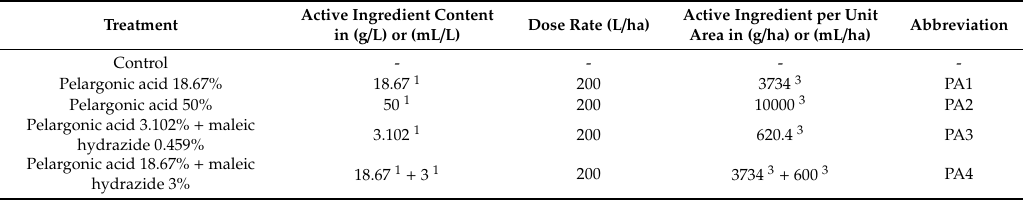
Table 2. The experimental treatments (e.g., natural herbicides) applied in the current study.